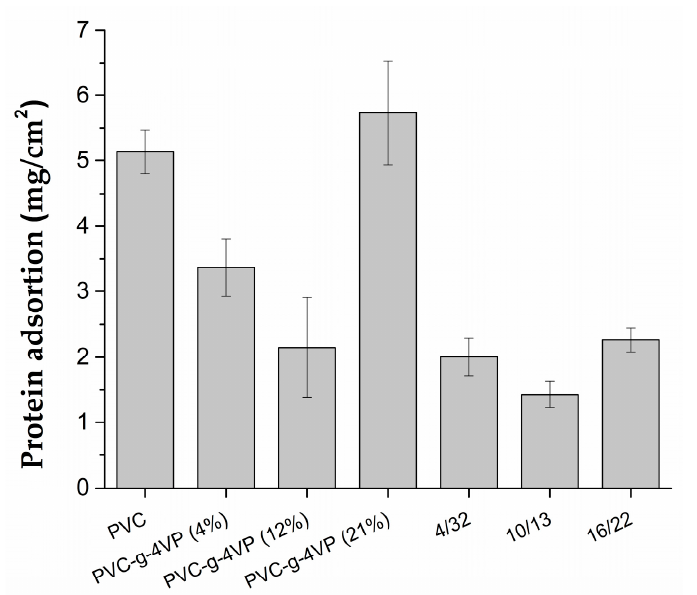
Figure 7. Protein adsorption on the polymer surface of different composition (incubation: 30% BSA Figure 7 . Protein adsorption on the polymer surface of di ff erent composition (incubation: 30% BSA solution in PBS, 37 ◦ C, 2 h). Reported: mean ± standard error of the mean, n = solution in PBS, 37 °C, 2 h). Reported: mean ± standard error of the mean, n = 3.